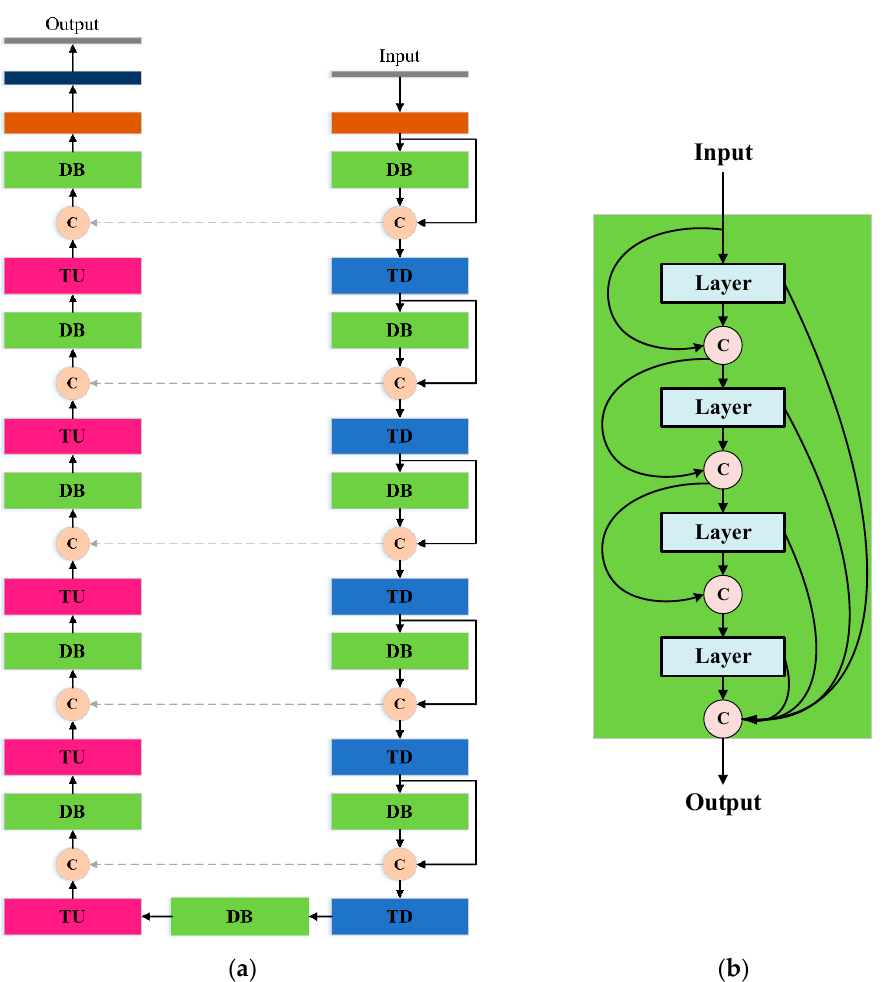
Figure 3. The network architecture of SED-2 (Dense U-Net): ( a ) Main architecture and ( b ) definition of dense block (DB) (Orange circle C means direct copy). Table 2. Architecture of SED-2 (Conv. stands for convolution, UP means up-sampling, [ ] denotes long range connection, [ ^ ] denotes superscript, and [ , ] denotes concatenate operation).